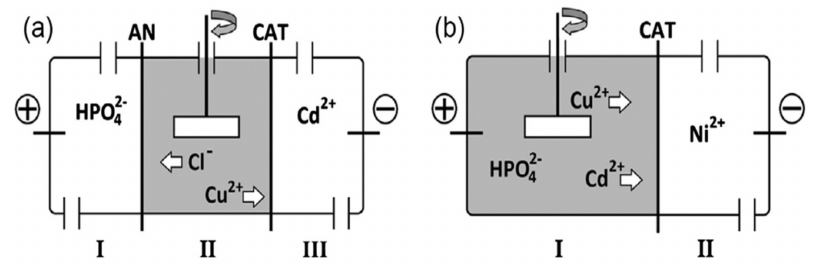
Figure 5. The ( a ) three-compartment and ( b ) two-compartment setup for the electrodialytic remediation of